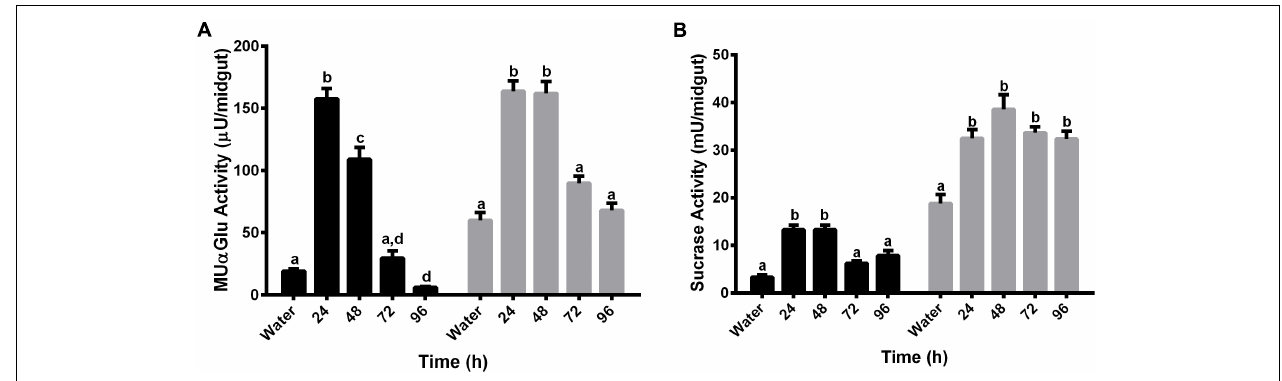
FIGURE 5 | α -glucosidase activity in different tissues of L. longipalpis females after feeding with blood. Activity was determined in midgut contents (black bars) and midgut tissues (gray bars) using MU α Glu (A) or sucrose (B) as substrates. Numbers in the x -axis represent the time elapsed after ingestion of blood. Water – females fed only with water for 3 days. The results are the mean ± SEM of three biological replicates each with n = 15. One-way ANOVA, followed by Tukey multiple comparison test. Different letters indicate statistically significant different groups, p < 0.05.